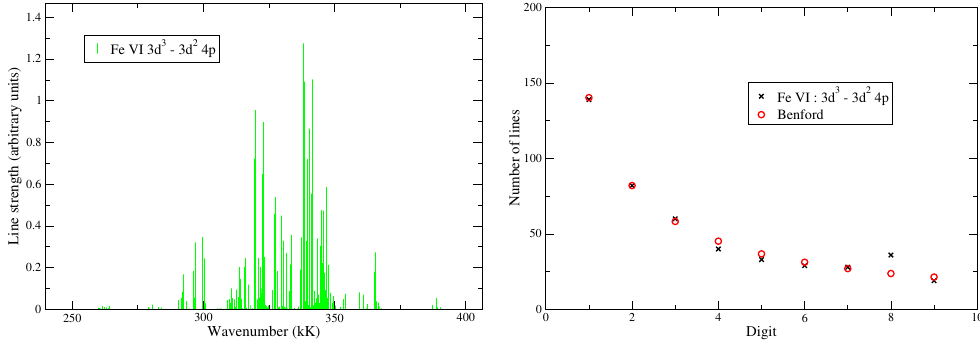
3 d 2 4 p (line strength as a function of energy) computed with Cowan’s Figure 6. Transition array 3 d 3 − code [56] and number of lines as a function of the first significant digit in the value of the strength.